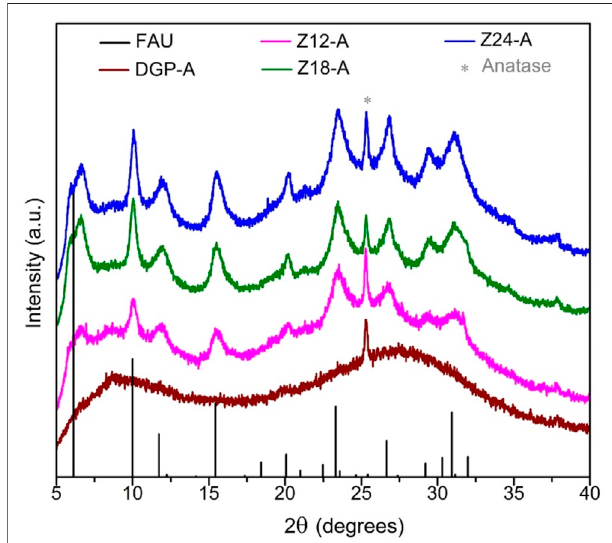
FIGURE 1 | Stacked powder X-ray diffraction patterns of MetaMax ® (black)comparedwithsamplesDGP-A(red)andDGP-W(blue).Smallimpurity of anatase (*) (TiO 2 at ∼ 25.3 ° 2 θ ; PDF card # 00-021-1272) is present in all three samples.